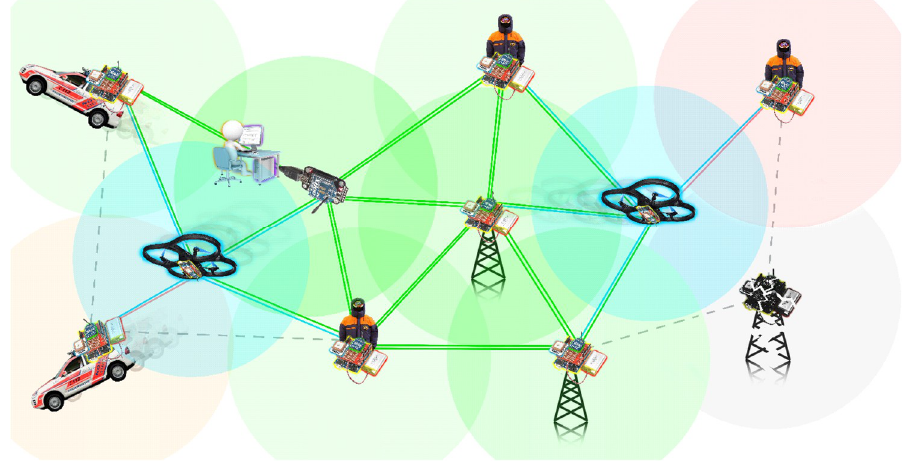
Figure 1. Self-organized wireless network.